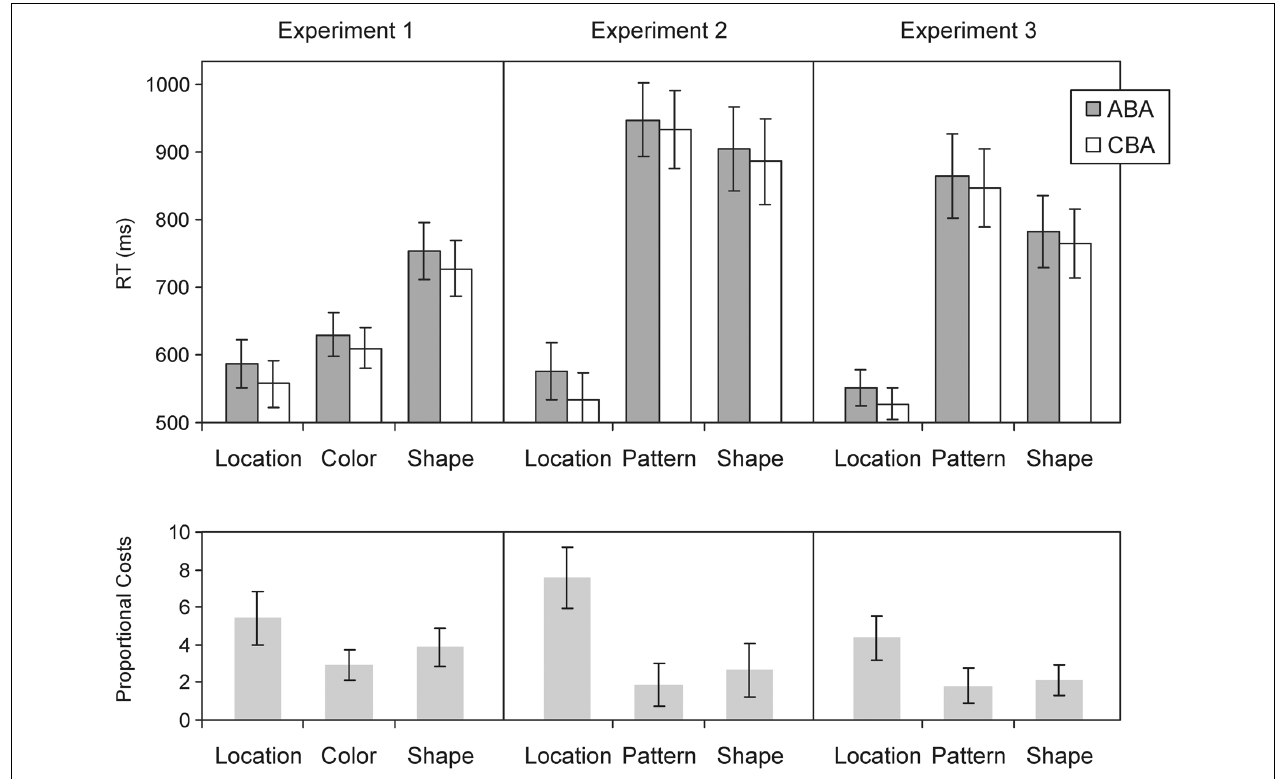
FIGURE 2 | (Top) Response times (RTs) in Experiments 1–3 as a function of task and sequence. (Bottom) Proportional scores of the n–2 repetition costs (proportional RT differences between ABA and CBA sequences) calculated to account for basic RT differences across the tasks. Error bars indicate one standard error of the mean. In all three experiments, RTs are smaller in the location than in the other tasks reflecting the “dominance” of the location task. In addition, robust n–2 repetition costs are also evident in all three experiments, that is, RTs are longer when the task from trial n–2 was repeated (ABA sequence) than when the task switched. Importantly, this effect was larger for the location than for the other tasks. This especially holds when the n–2 repetition costs are set in relation to the absolute RTs in each task (see the proportional scores in the lower row of the